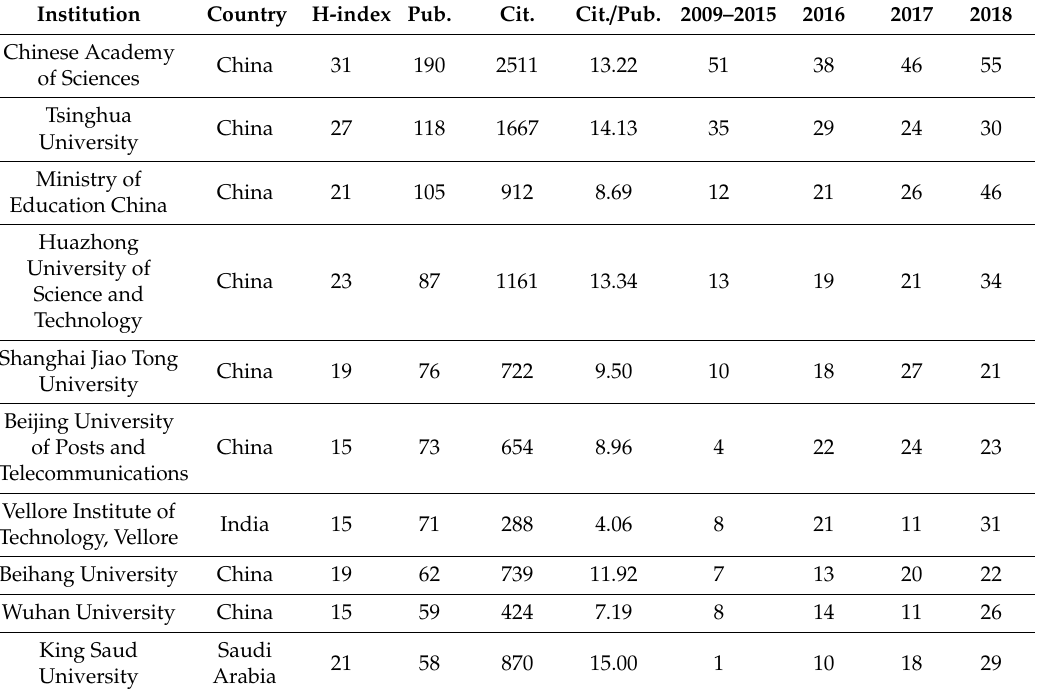
Figure 6. Top 10 most productive institutions in big data research. Table 3. Top 10 productive Institutions in big data research.